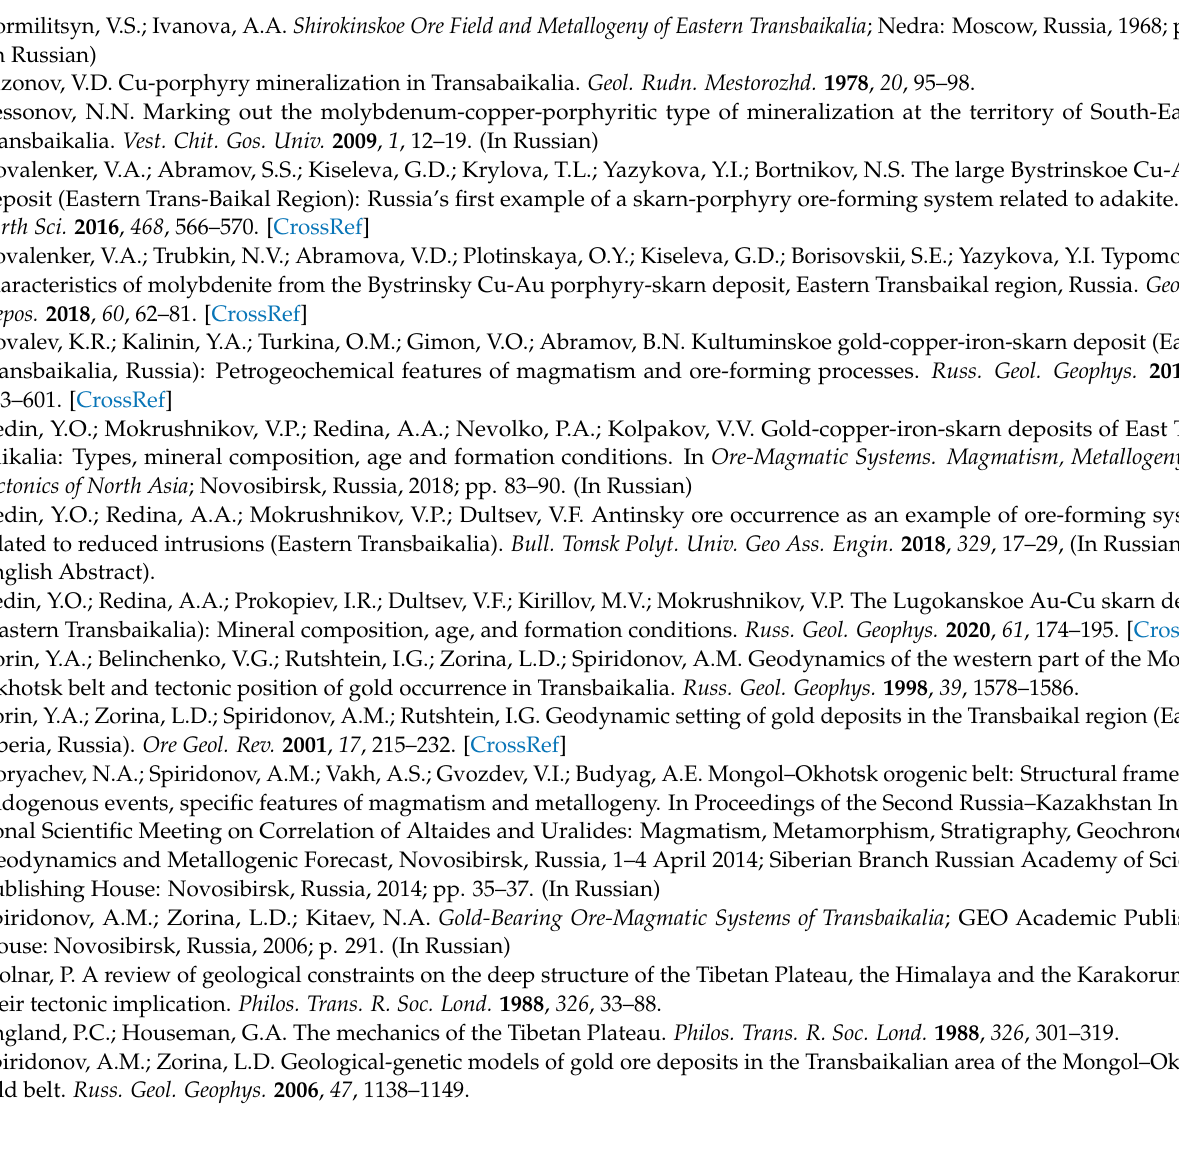
Supplementary Materials: The following are available online at https://www.mdpi.com/article/10.339 composition; Table S4: Norbergite composition; Table S5: Tremolite composition; Table S6: Actinolite composition; Table S7: Lollingite composition; Table S8: Arsenopyrite composition; Table S9: Pyrite composition; Table S10: Alloclasite composition; Table S11: Chalcopyrite composition; Table S12: Sphalerite composition; Table S13: Galena composition; Table S14: Fahlores composition; Table S15: Boulangerite composition; Table S16: Native gold composition; Table S17: Zircon LA-ICP-MS U-Pb